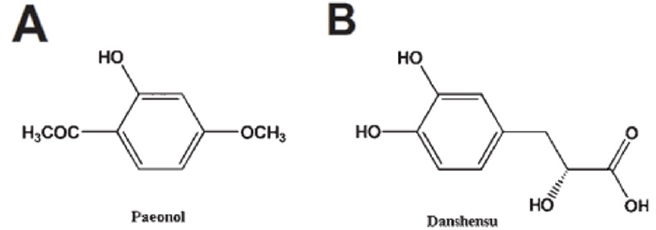
Figure 1. Chemical structures of Pae ( A )